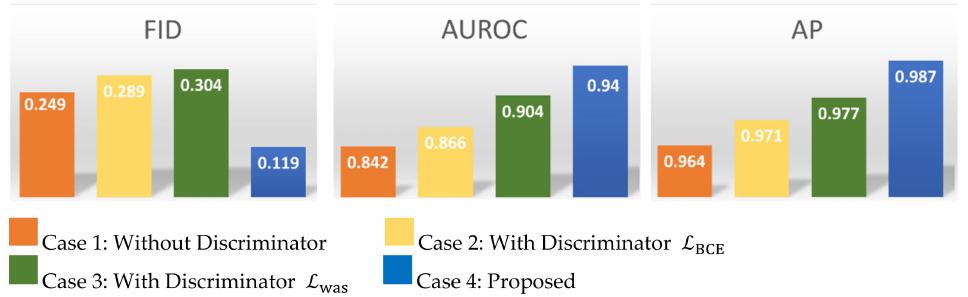
Figure 6. The results of the ablation experiment. Blue is the proposed method, orange is the condition without discriminator, golden is the condition with discriminator L BCE , and green is the condition with discriminator L was